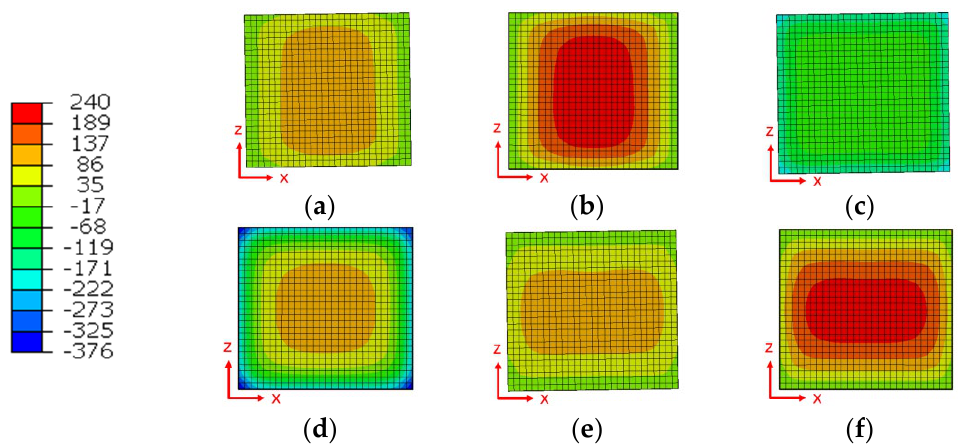
Figure 11. Stress field of welding surface during the cooling process; ( a ) X stress with cooling time of 1 s; ( b ) X stress after cooling process; ( c ) Y stress with cooling time of 1 s; ( d ) Y stress after cooling process; ( e ) Z stress with cooling time of 1 s; ( f ) Z stress after cooling process.